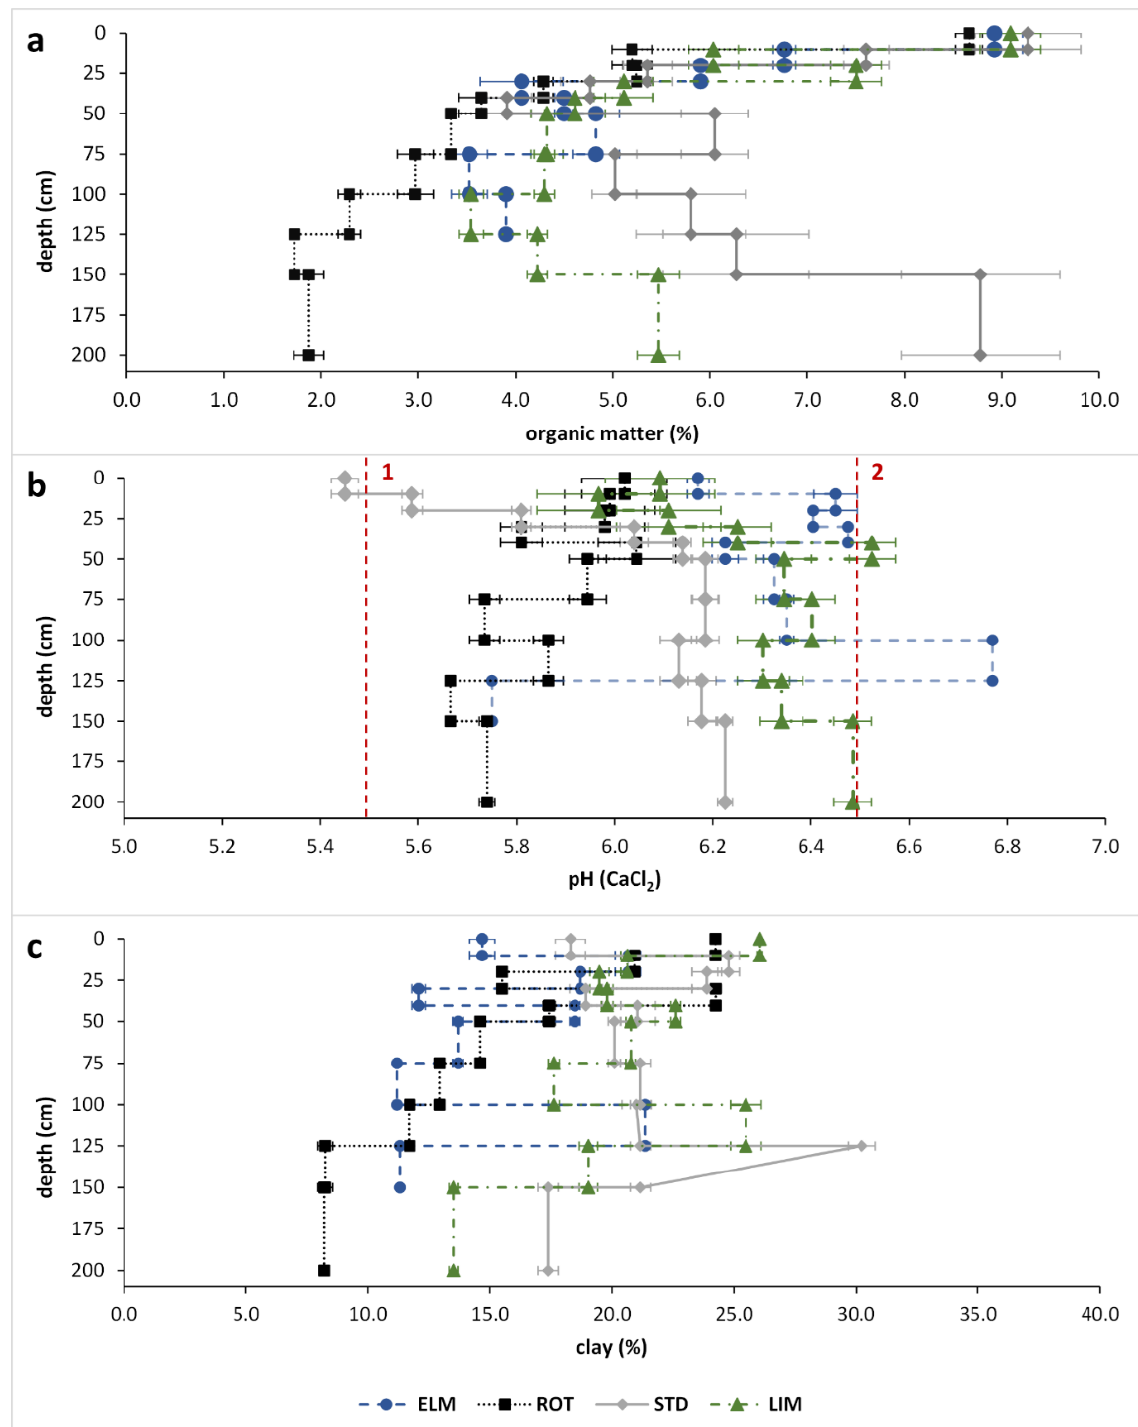
Figure 2. Floodplain soil properties for sampling areas. ( a ): Organic matter content (%) according to LOI analyses (maximum outliers excluded); ( b ): pH (-) values with mobilization limit values (1: Cd; 2: Zn, Ni, Co, As; according to Blume et al., 2004); ( c ): clay content (%).